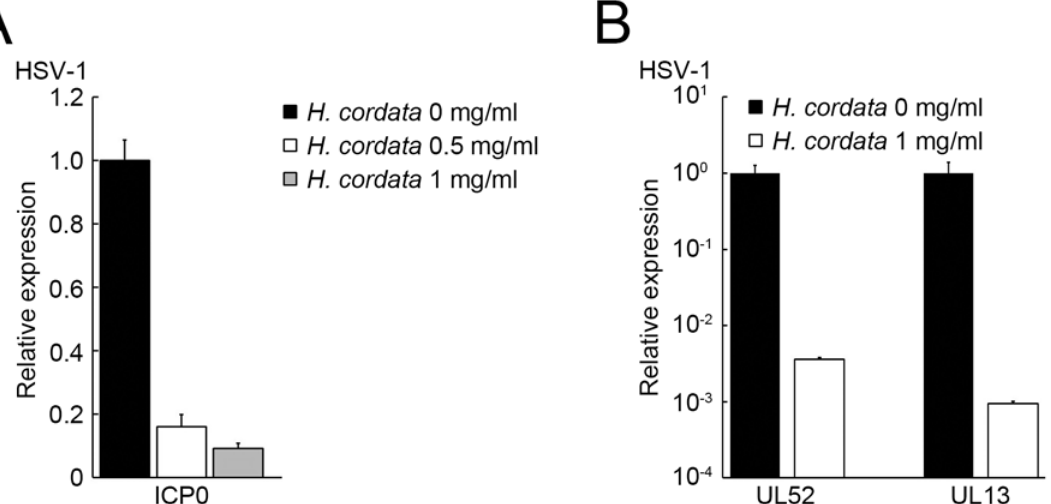
Figure 7. HCWEs suppress the gene expression of HSV-1. (A) 1X10 6 Vero cells were infected with HSV-1 at 1 m.o.i. in the presence or absence of HCWEs. RNAs were extracted from the virus-infected cells at 2 h.p.i. and analyzed for viral ICP0 expression. (B) RNAs were extracted at 10 and 16 h.p.i. and analyzed for viral UL52 and UL13 gene expressions,